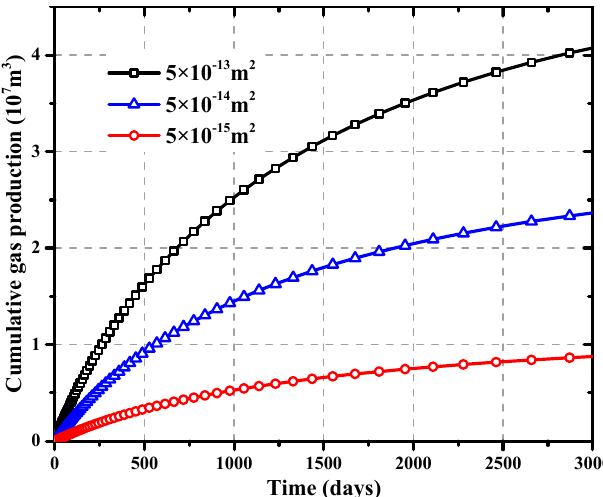
Figure 11. Effects of initial fracture permeability on cumulative gas production.